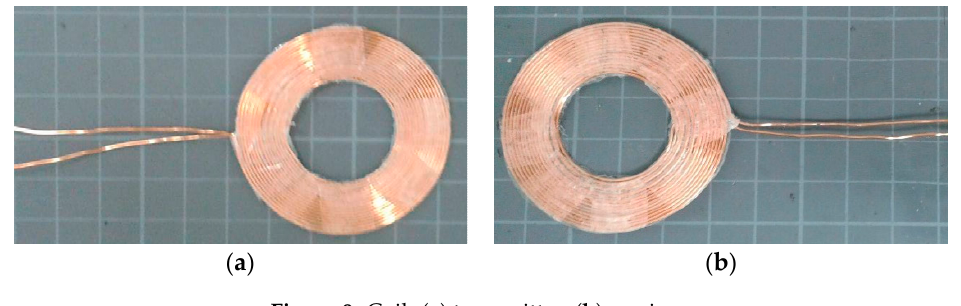
Figure 9. Coil: ( a ) transmitter; ( b ) receiver.